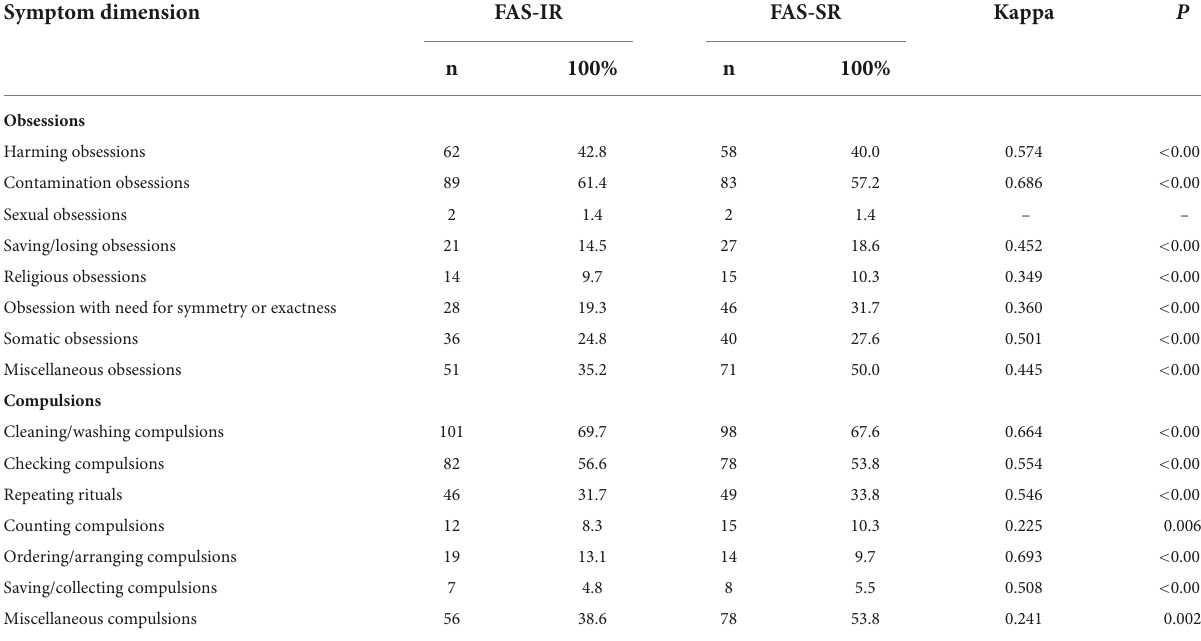
TABLE 2 The agreement in relatives’ endorsement of patient OCD symptom categories on FAS-IR vs. FAS-SR ( n = 145). Symptom dimension